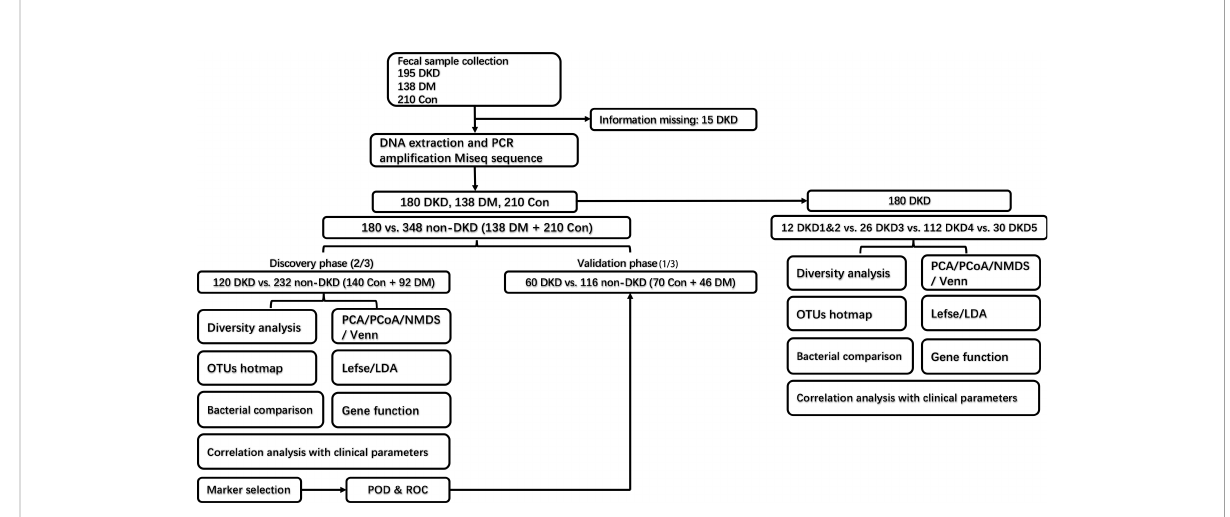
FIGURE 1 Experimental fl owchart. DKD, diabetic kidney disease; DM, diabetes mellitus; Con, healthy controls; OTU, operational taxonomy